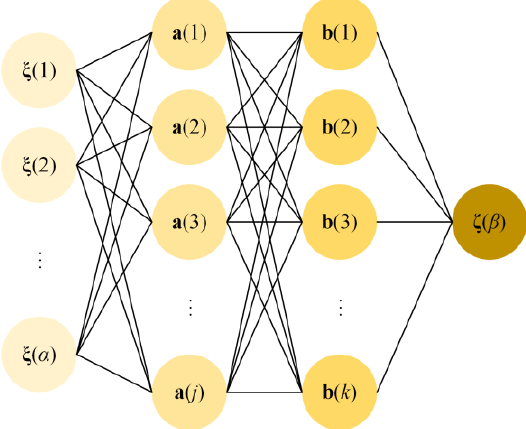
Figure 3. The structure of the neural network.